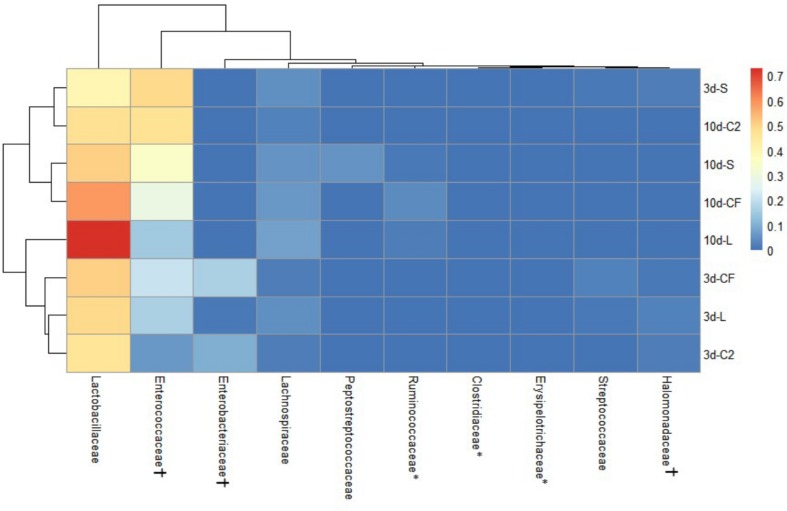
Double hierarchical dendrogram of bacterial distribution within in ovo treatments over time in upper ileum. The taxonomic association of bacterial families is depicted in the columns. Hierarchical clustering in the rows is based on the composition similarity between treated samples. Heatmap plot represents the mean relative percentage of each bacterial family within samples treated with either saline (S), LAB-probiotic (L), Citrobacter freundii (CF) or Citrobacter spp. (C2) at 3 or 10 days of age. Statistical differences (P < 0.05) between groups were reported for each bacterial population (†) by 3 days of age and (∗) 10 days of age.